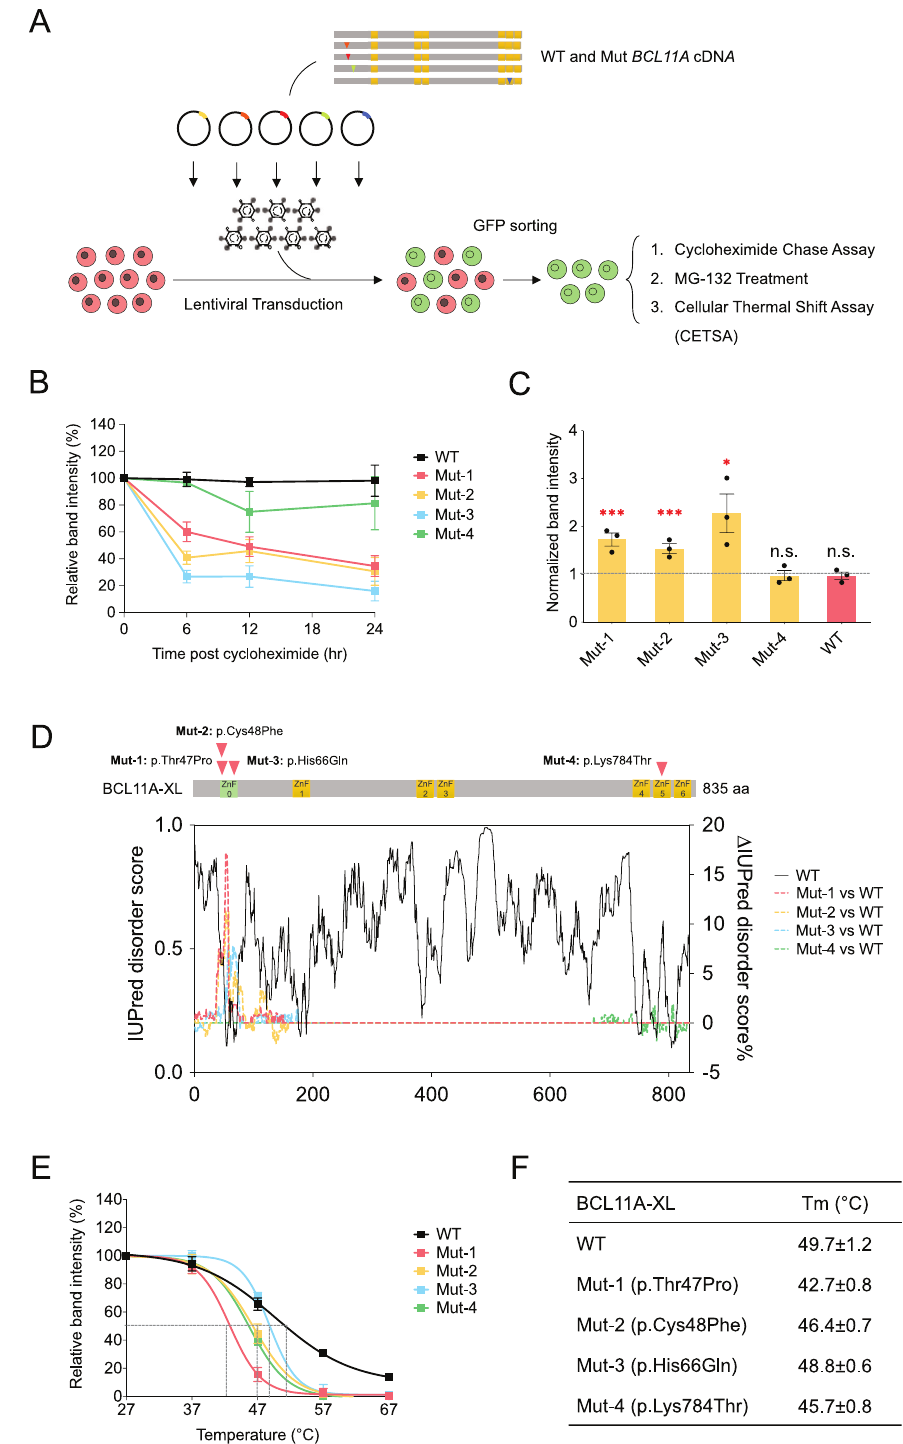
Fig 3. Examining protein stability and cellular thermal shifts of BCL11A missense variants. (A) Workflow of exogenous expression of either the wild type or mutant forms of the BCL11A XL in K562 cells showing lentiviral transduction, GFP sorting, protein stability and cellular thermal shifts assays. (B) Quantitative representation of BCL11A levels for Cycloheximide Chase Assay from exogenous wild type or mutant forms of the BCL11A XL cDNA expression in K562 cells. Cells were treated with 25 μ g/ml cycloheximide to arrest ongoing protein synthesis and